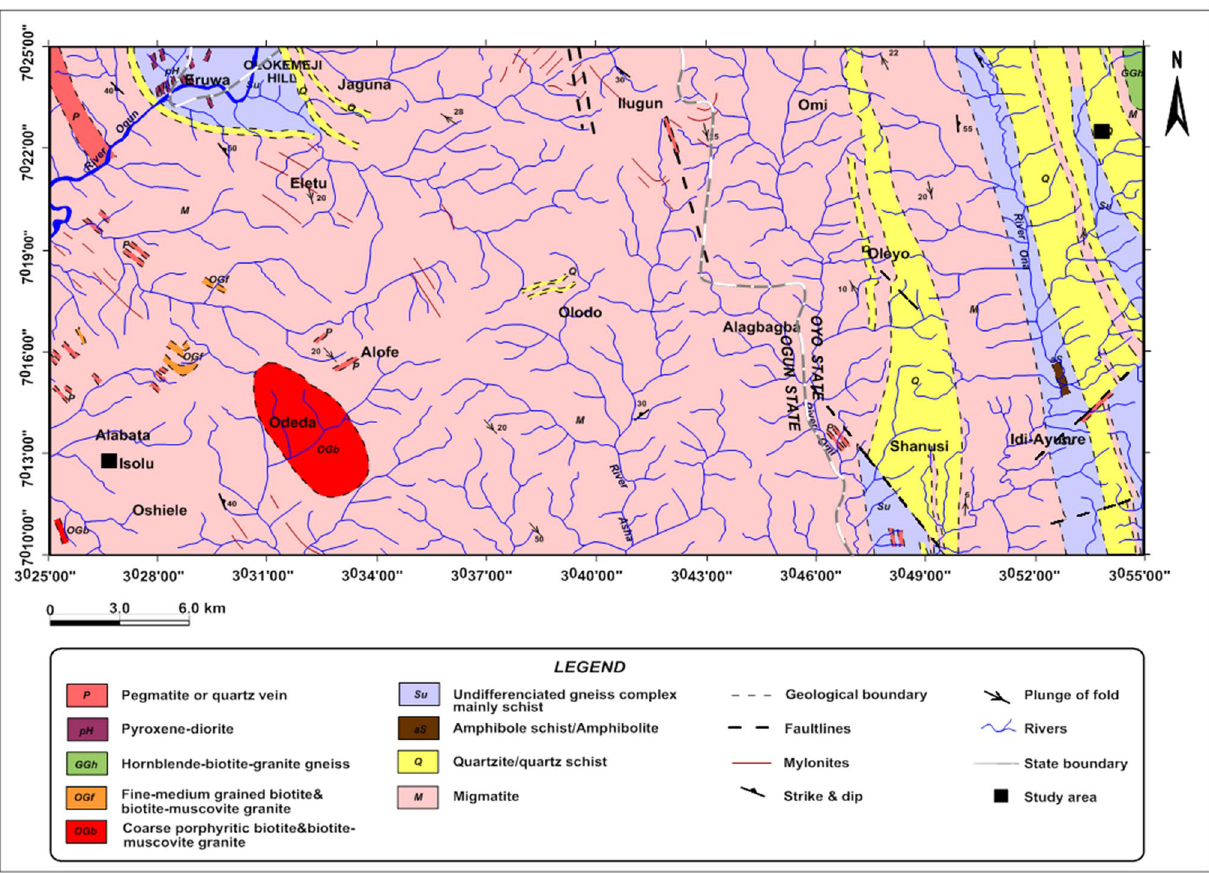
Fig. 2 Geological map showing soil sampling locations. Adapted from Jones and Hockey